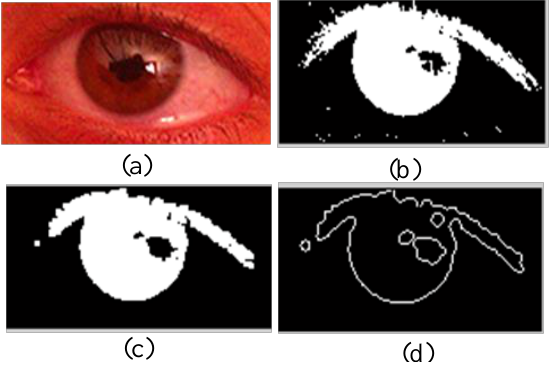
Figure 2. Flow diagram of thresholding method.